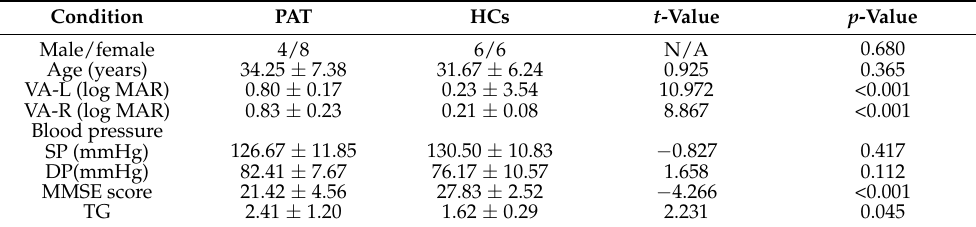
Table 1. Basic information of all participants.